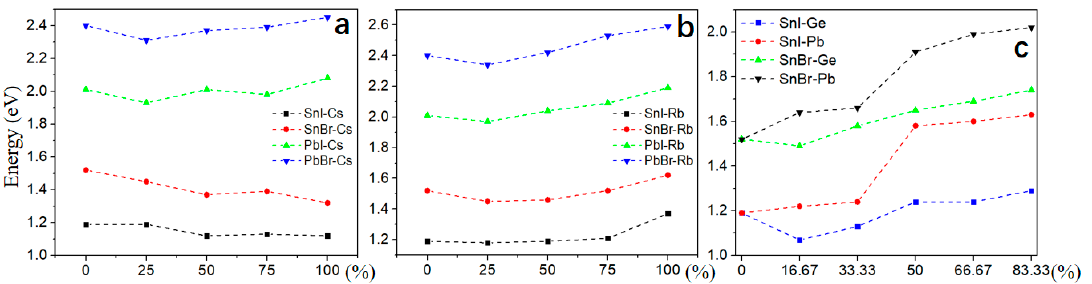
Figure 3. Bandgaps of BA 2 MA 2 B 3 X 10 (B = Pb 2+ or Sn 2+ ; X = Br − or I − ) mixed with ( a ) Cs atom and ( b ) Rb atom. ( c ) Bandgaps of BA 2 MA 2 Sn 3 I 10 mixed with Ge or Pb atom.